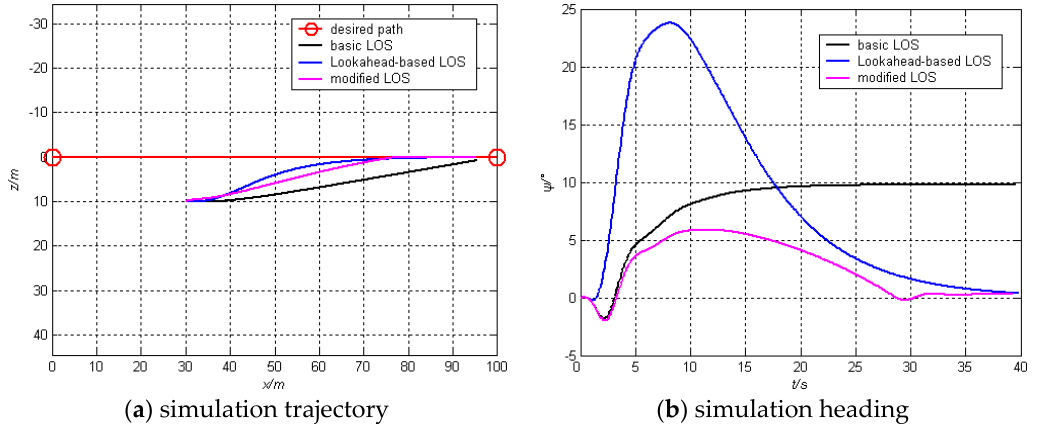
Figure 19. Introducing of lateral movement.